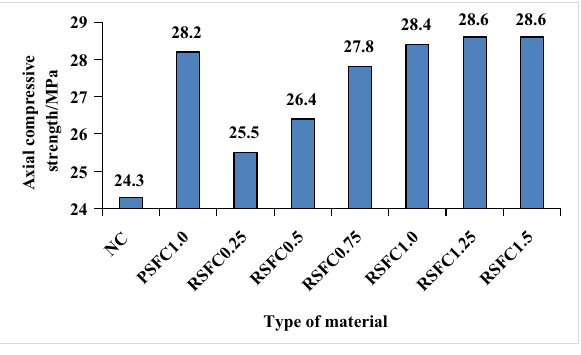
Figure 16: Failure mode of concrete axial